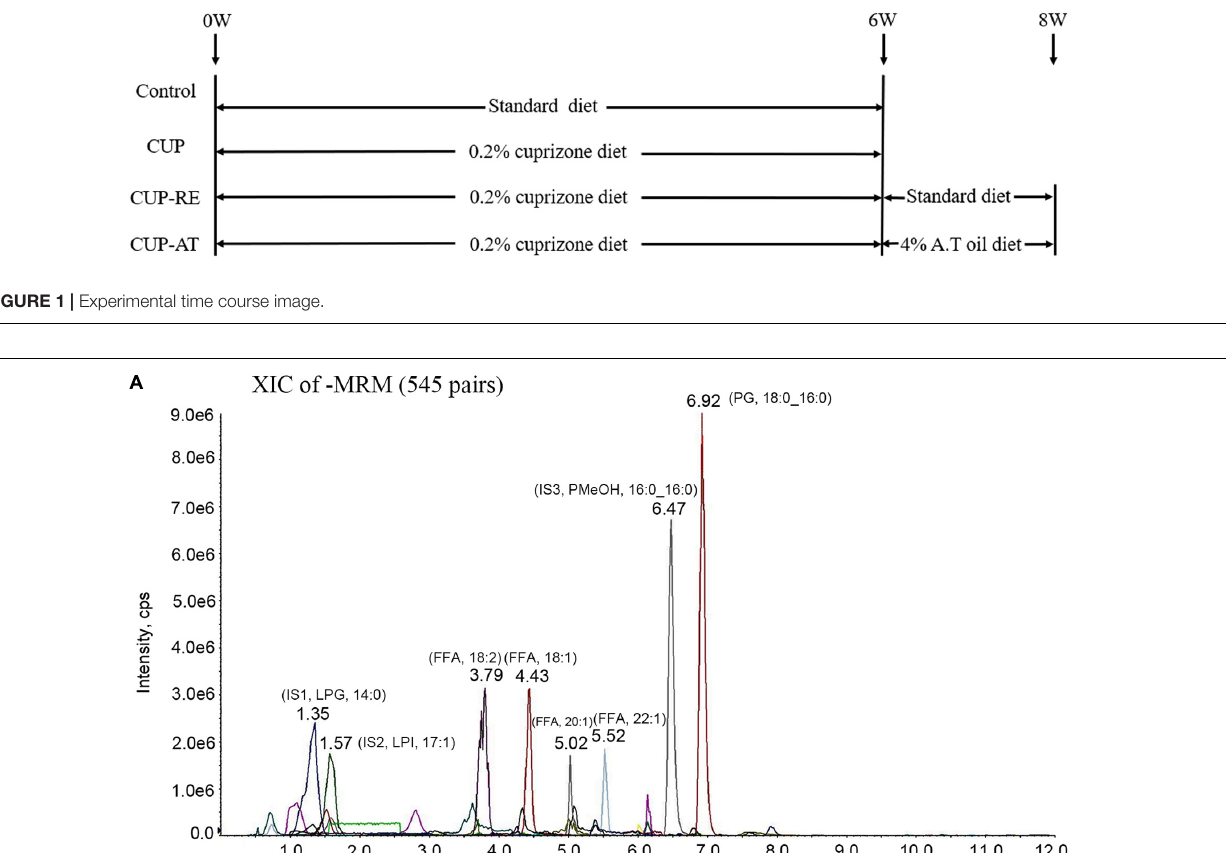
Frontiers in Neuroscience |